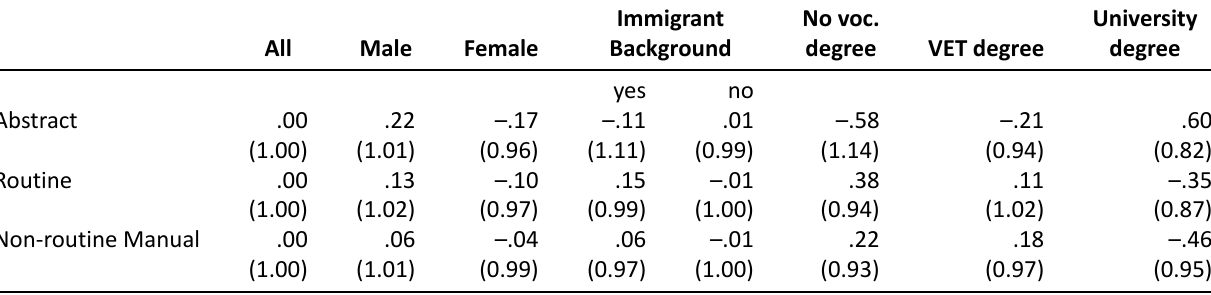
Table 2. Means and standard deviations (in parentheses) for standardized task scales by major demographic and education groups. Source: BIBB/BAuA Employment Survey 2012 and Supplemental Task Survey to the Employment Survey